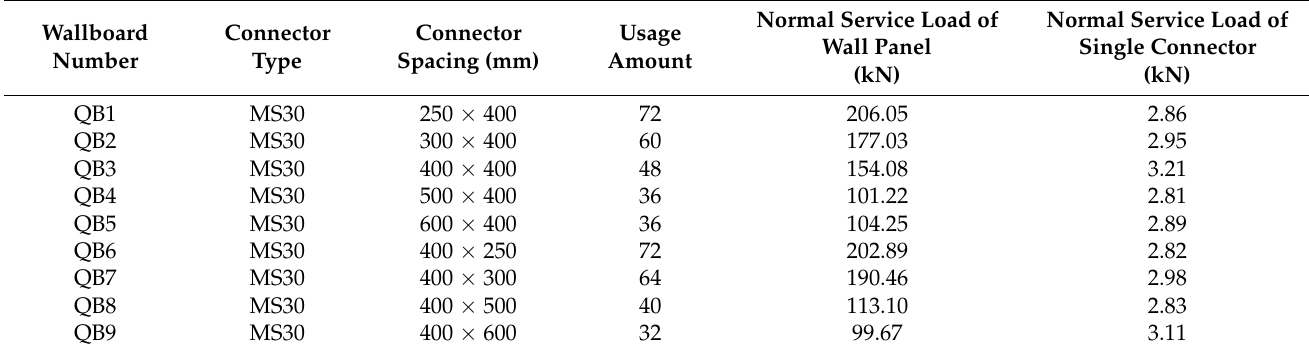
Table 9. Wallboard loads under different transverse and longitudinal spacings.